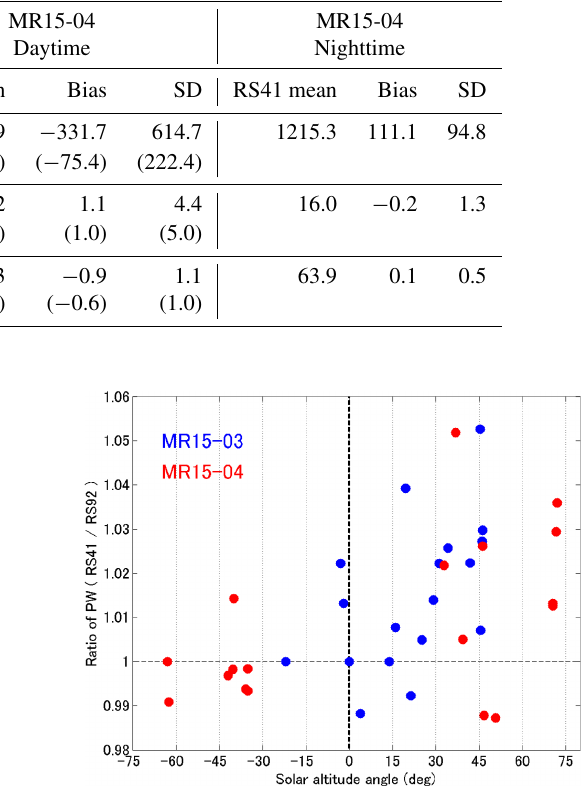
Figure 10. The ratio of the RS41 to the RS92 PW as a function of solar altitude angle. Blue and red dots represent soundings in the MR15-03 and MR15-04 cruises,